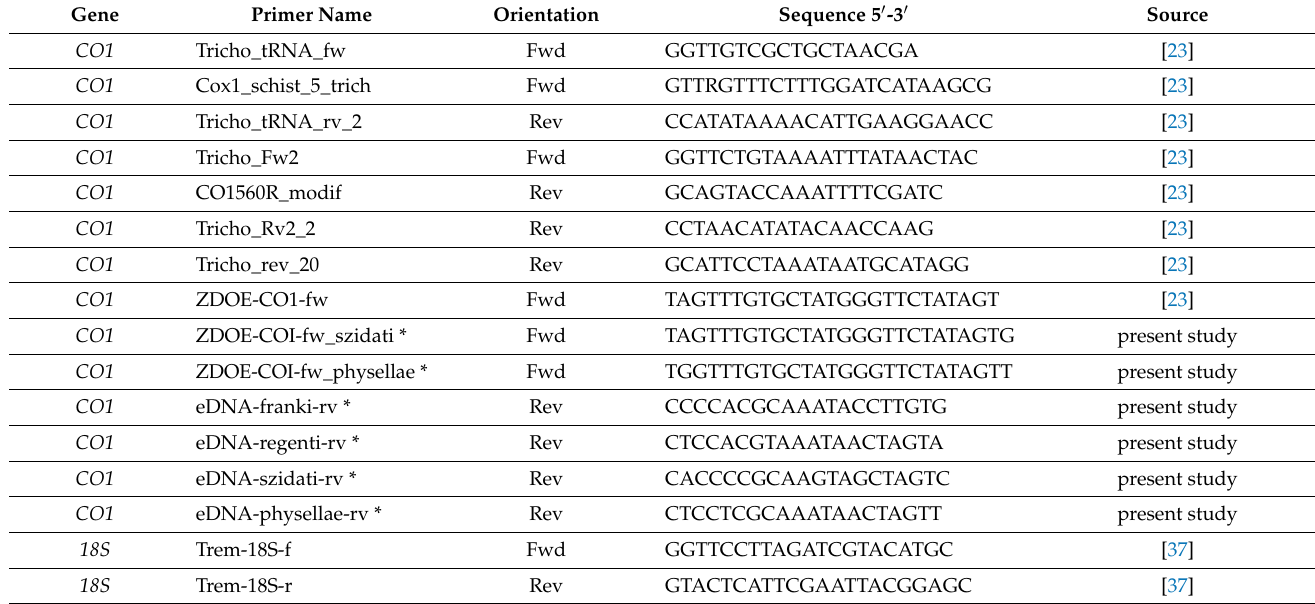
Table 3. List of CO1 and 18S PCR primers used. Primer Tricho_tRNA_fw binds in the adjacent tRNA